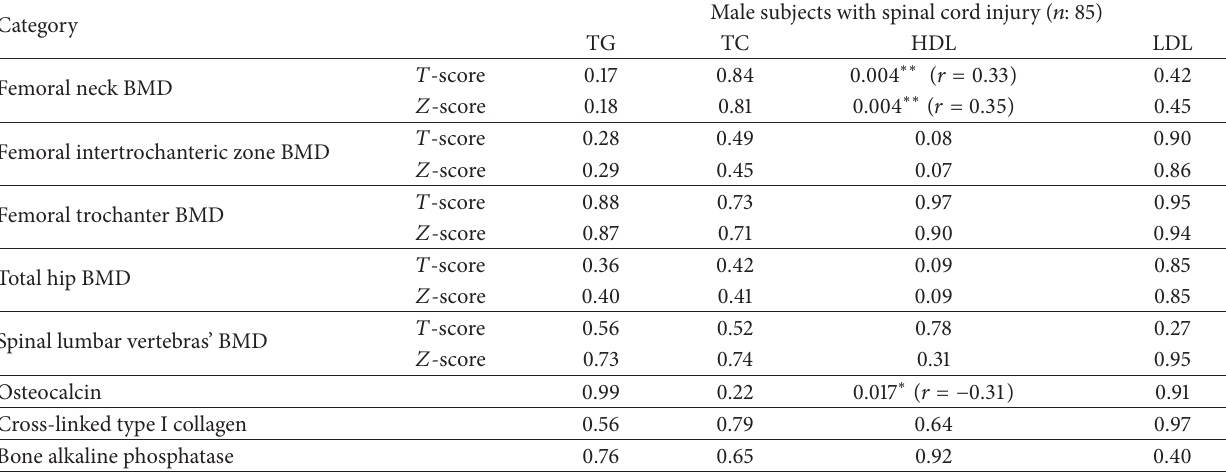
Male subjects with spinal cord injury ( 𝑛 :